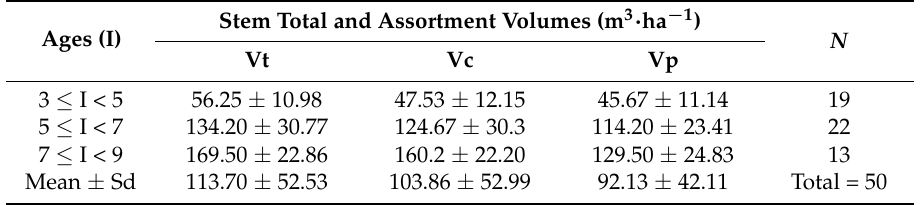
Table 2. Summary of stem volumes computed in the 50 field sample plots.